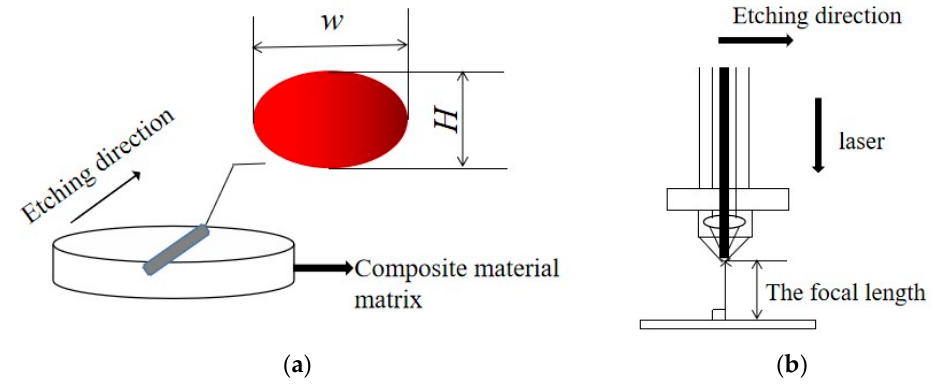
Figure 2. ( a ) Diagram of melting point; (b) cutting schematic diagram.